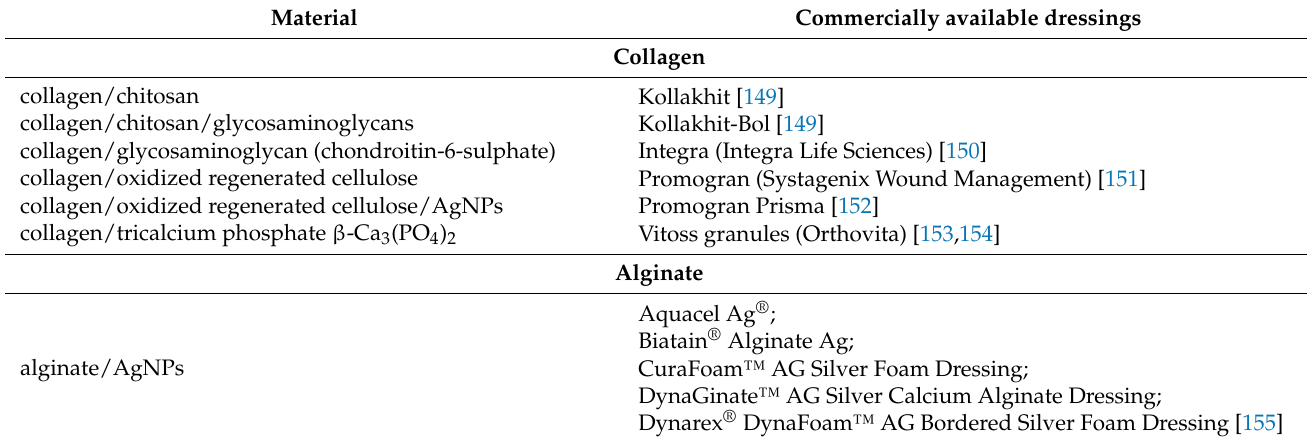
Table 1. Materials based on collagen and alginate in the form of commercially available